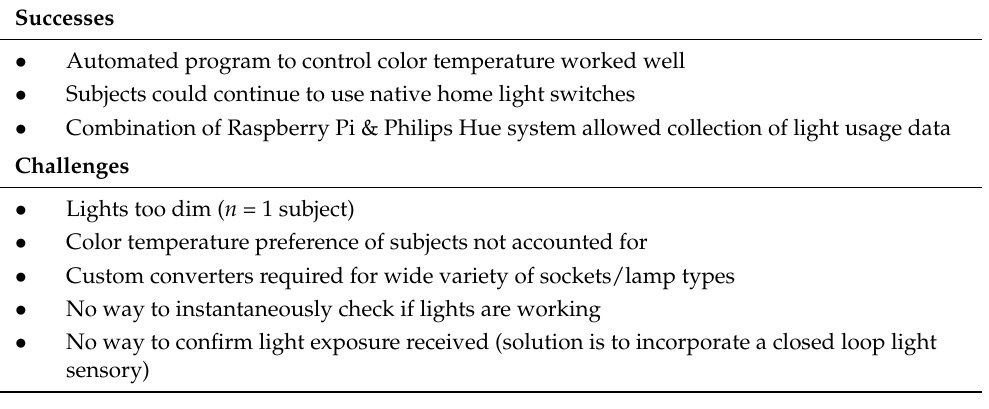
Table 1. Feasibility and participant